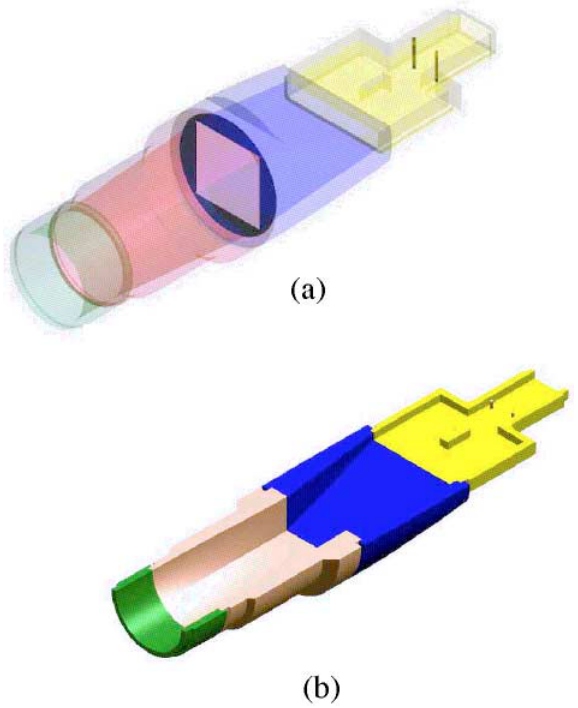
FIG. 7. (Color) (a) The circular-to-rectangular-tapers TE 12 mode transducer. (b) A cutaway view of the structure.